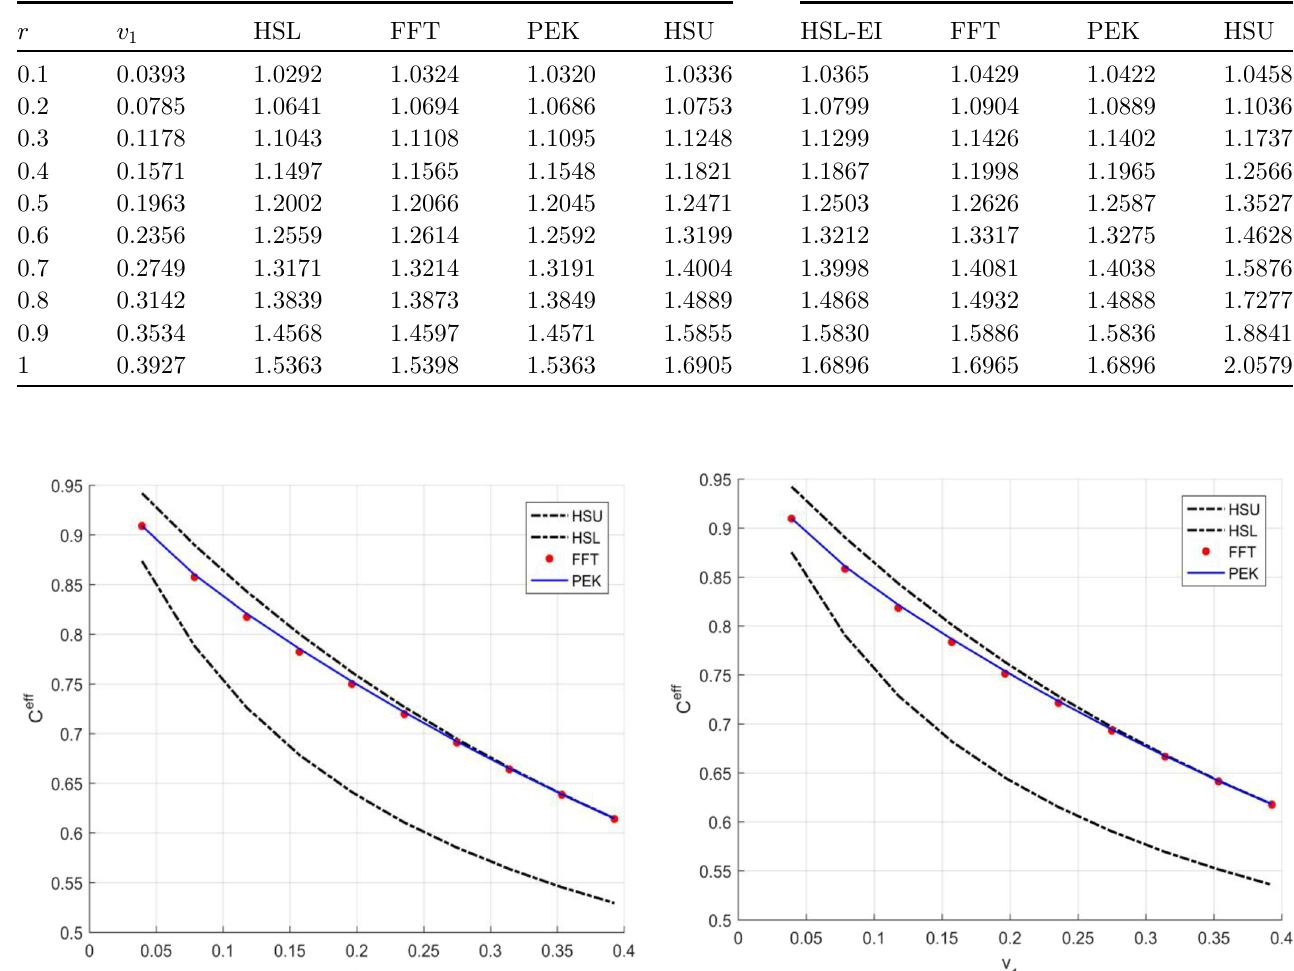
Table 3. Comparison of results ( C eff ) of FFT and PEK for square model, a = 0.05, a